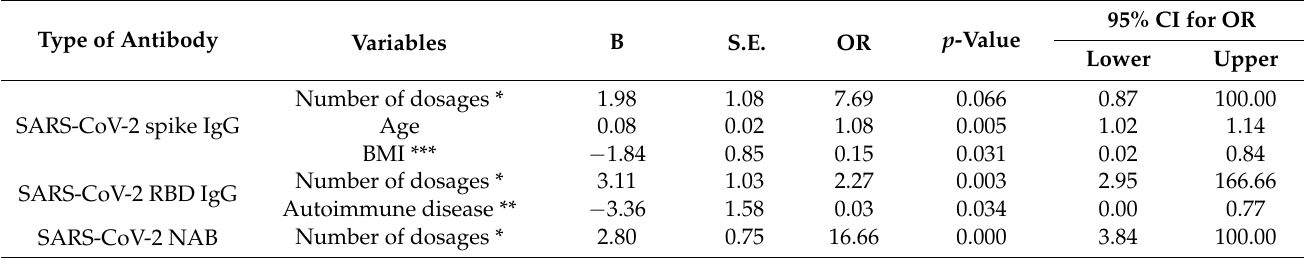
Table 4. Logistic regression analysis predicting the positivity of